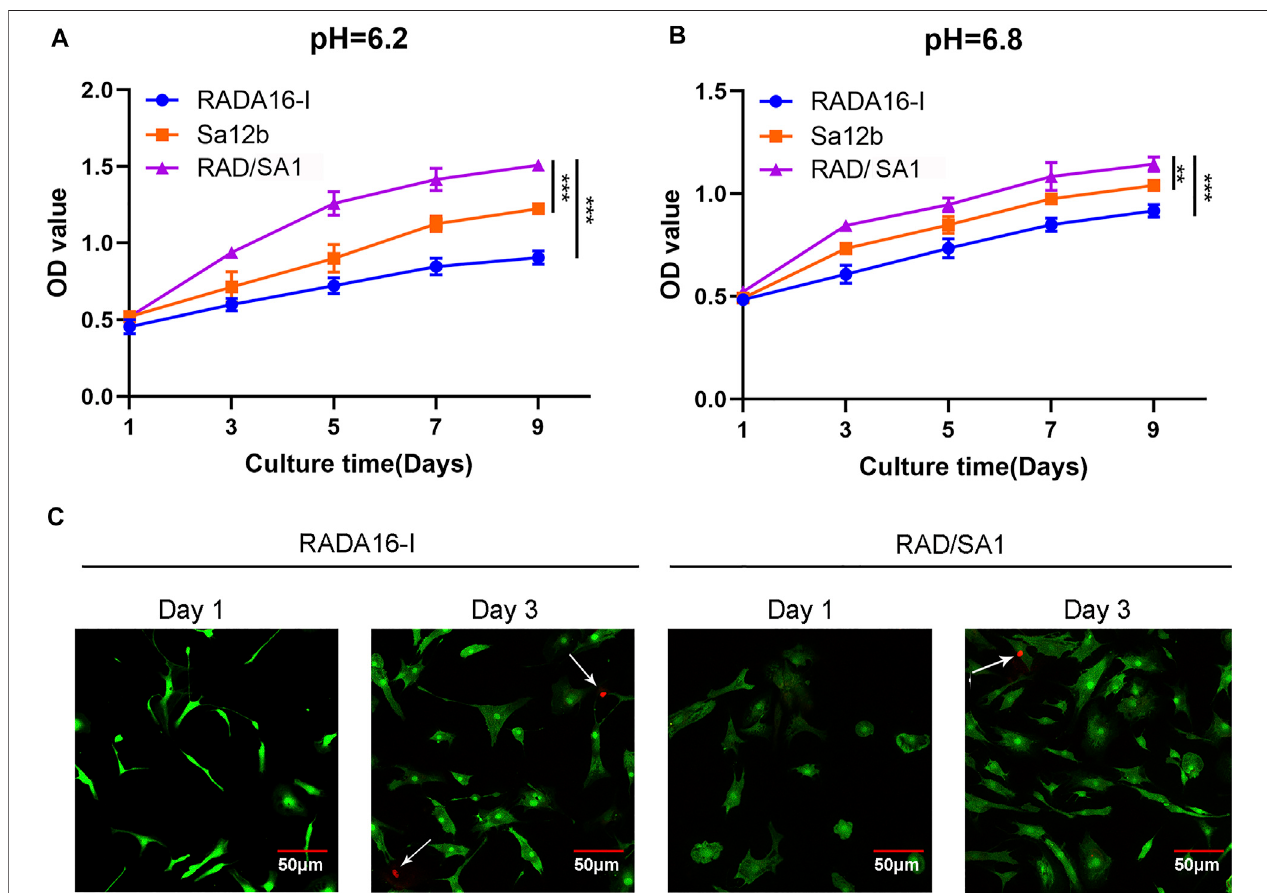
FIGURE5| CCK-8-basedquanti fi cationanalysisdemonstratedthattheamountofhNPMSCs3DculturedinRAD/SA1weresigni fi cantlyhigherthanthosecultured inSa12bandRADA16-Ifor1day,3,5,7and9 days,respectively.Whenthetwogroupscompared,**indicates p < 0.01and***indicates p < 0.001. (A) hNPMSCswere culturedatpH6.2. (B) hNPMSCswereculturedatpH6.8. (C) LiveanddeadcellviabilityassayforhNPMSCsthatwere3DculturedinRADA16-IandRAD/SA1for1and 3 days, respectively. The green fl uorescent cells are the live cells labeled with CAM, and the red fl uorescent cells indicated by white arrows are dead cells labeled with